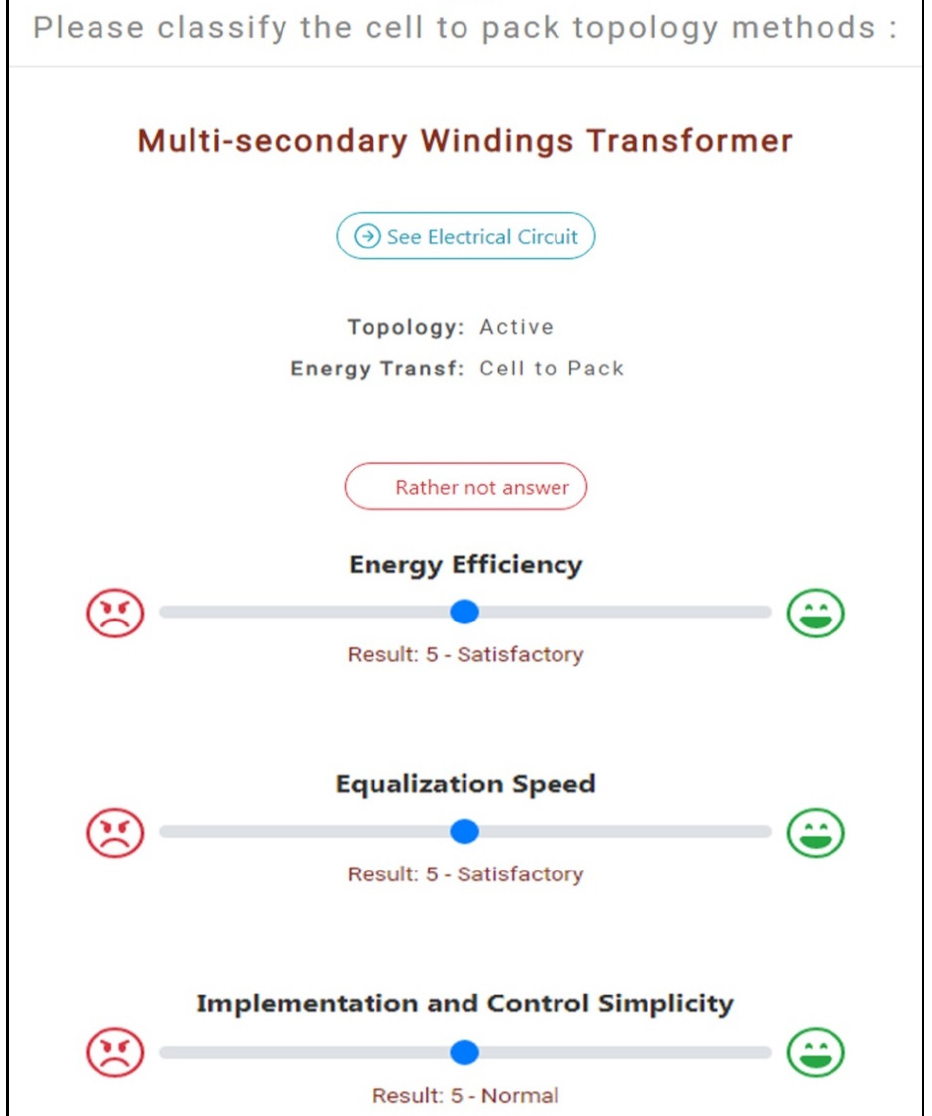
Figure 3. Multiplatform browser application developed to ask and to obtain the AHP numerical scale for the energy efficiency, equalization speed, and implementation and control simplicity of the 24 SoC equalization methods. Table 6. Survey result for the numerical scale for the energy efficiency, equalization speed, and implementation and control simplicity of the SoC equalization methods.